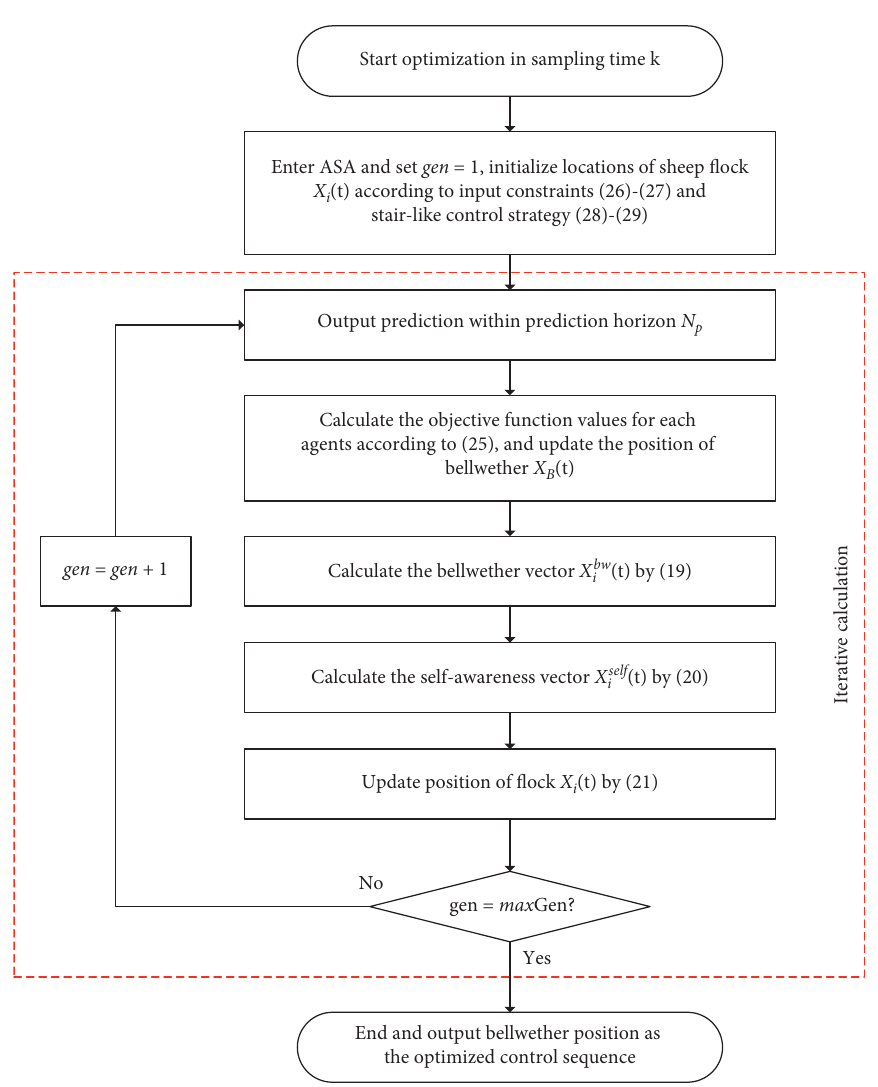
Figure 12: Flow chart of rolling optimization process based on ASA.